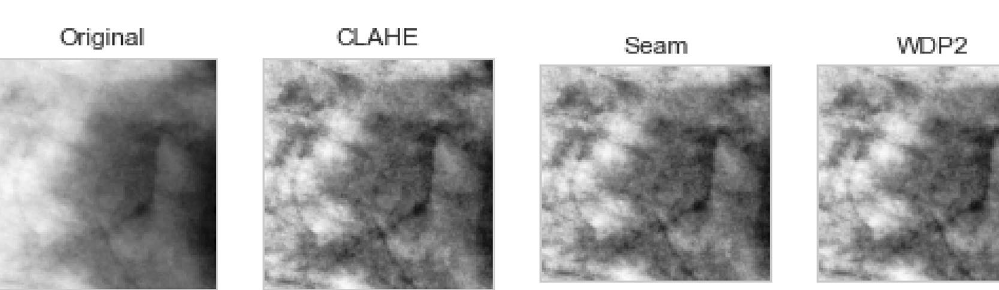
Figure 11. A progressive display of the preprocessing methods applied to a sample image from the data sources. The original image, its corresponding CLAHE-operated version, its corresponding seam-carving- operated version, and its wavelet-operated version.